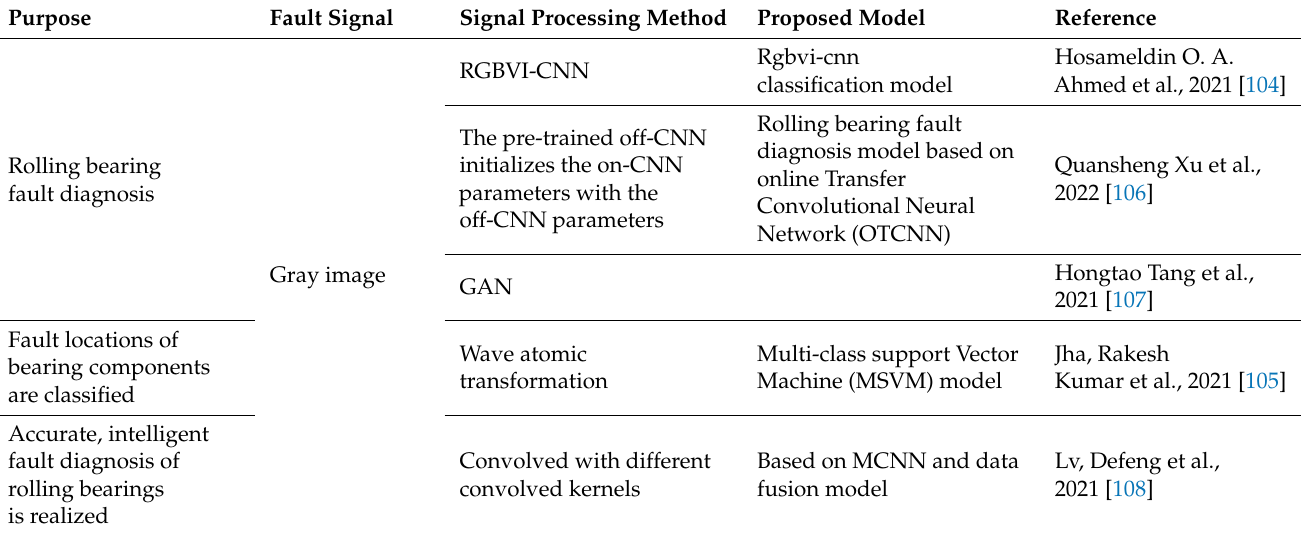
Table 10. Summary and comparison table of grayscale image methods.